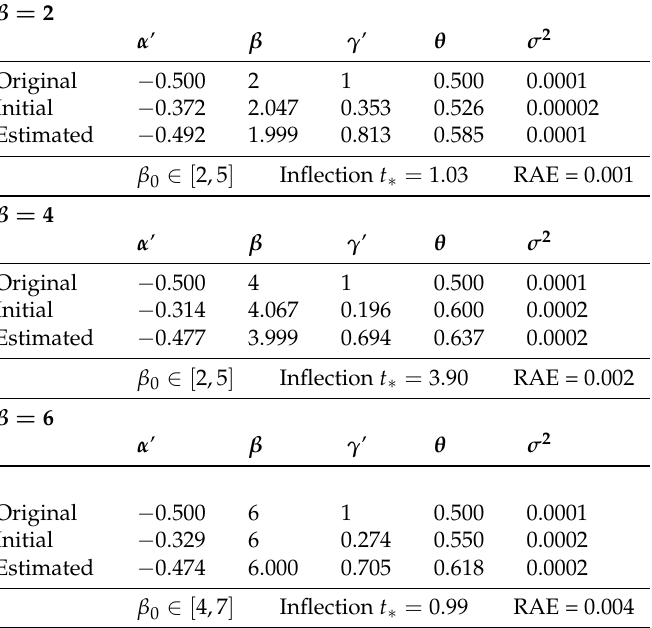
Figure 8. Simulated and estimated mean functions for variations of parameters of Table 5. Table 5. Results for simulated lognormal diffusion with different